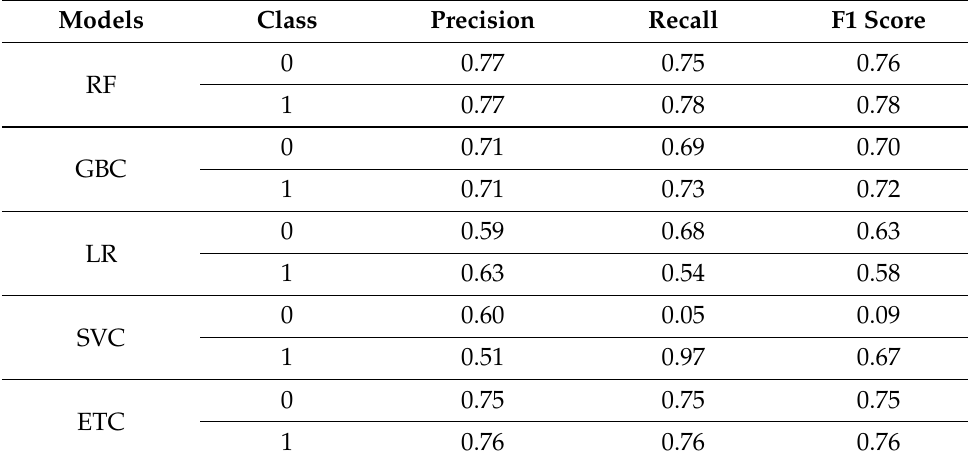
Table 13. Per-class accuracy using the original features.